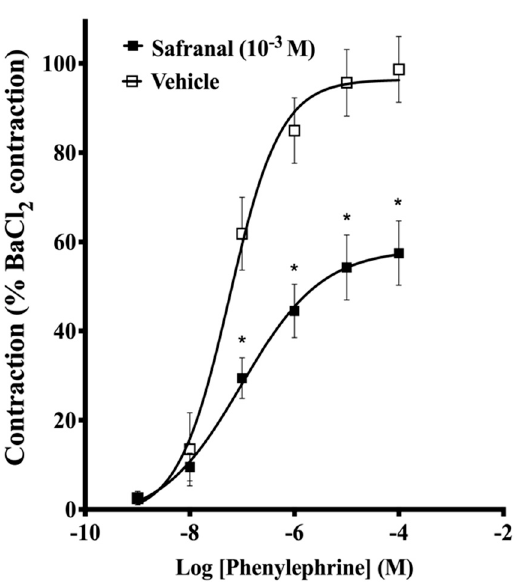
Figure 3. Effect of 10 − 3 M safranal on the concentration–response curves of Phe (10 − 9 –10 − 4 M) in aortic rings. Contractile responses are expressed as the percentage of maximum contraction evoked by BaCl 2 (3 × 10 − 3 M). Data are the means ± SEM of 6 experiments. * indicates significant difference at p < 0.05 compared to the vehicle.